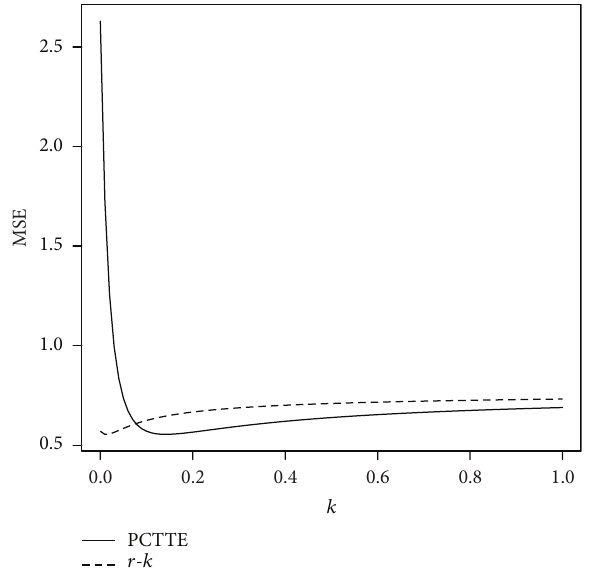
Figure 7: The MSE values of LTE and PCTTE when 𝑘 = 0.8